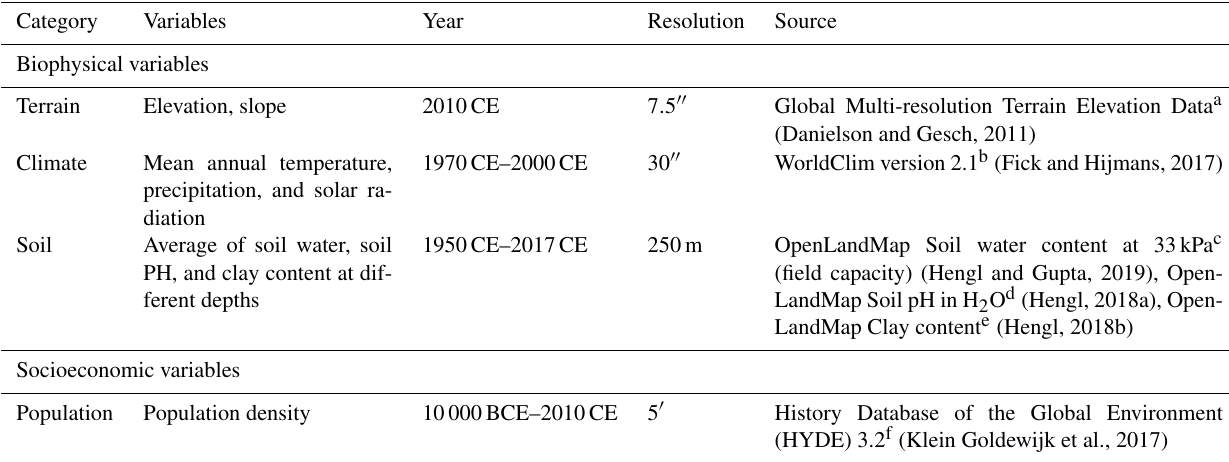
Table 1. Variables for cropland suitability